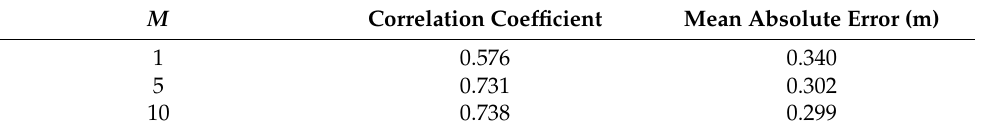
Table 4. Error statistics for 60 s radar predictions versus buoy